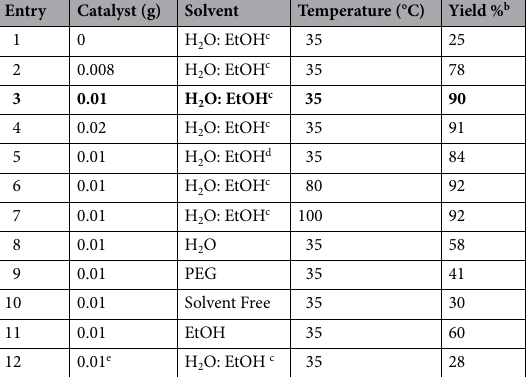
Table 5. Optimization of reaction condition for synthesis of 1,4-dihydropyrano[2,3-c]pyrazole under different conditions a . a 4-Chlorobenzaldehyde (1 mmol), malononitrile (1 mmol), ethyl acetoacetate (1 mmol), hydrazine hydrate (1 mmol), 20 min. b Pure yield. c Ratio: 2:1 mL. d Ratio: 1:1 mL. e The reaction catalyzed by HMS/Pr-Xa. Significant values are in